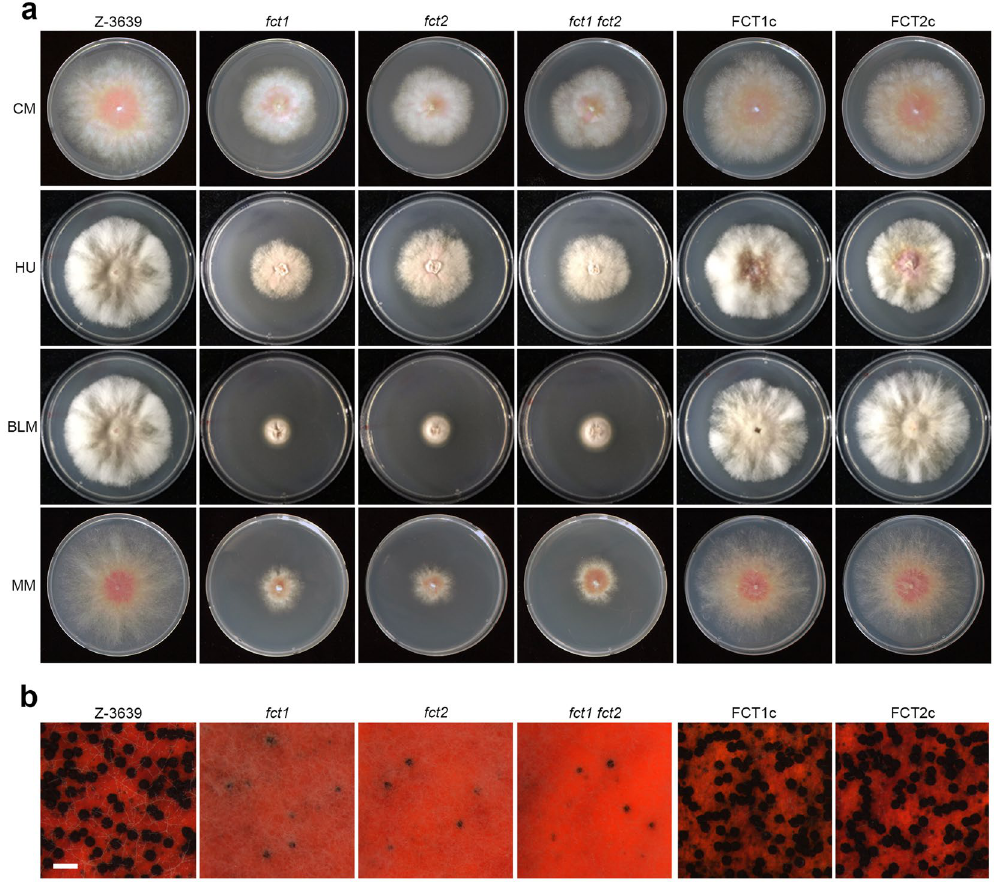
Figure 3. Vegetative growth and sexual development of F. graminearum strains. ( a ) The mycelial growth of F. graminearum strains on complete medium (CM), CM supplemented with 10 mM hydroxyurea (HU), 10 mU/ ml bleomycin (BLM), and minimal medium (MM). The strains were imaged 5 days after inoculation. ( b ) Sexual development. A five-day-old culture on carrot agar medium was mock-fertilized to induce sexual reproduction, and the cultures were incubated for an additional 7 days. Scale bar = 500 µ